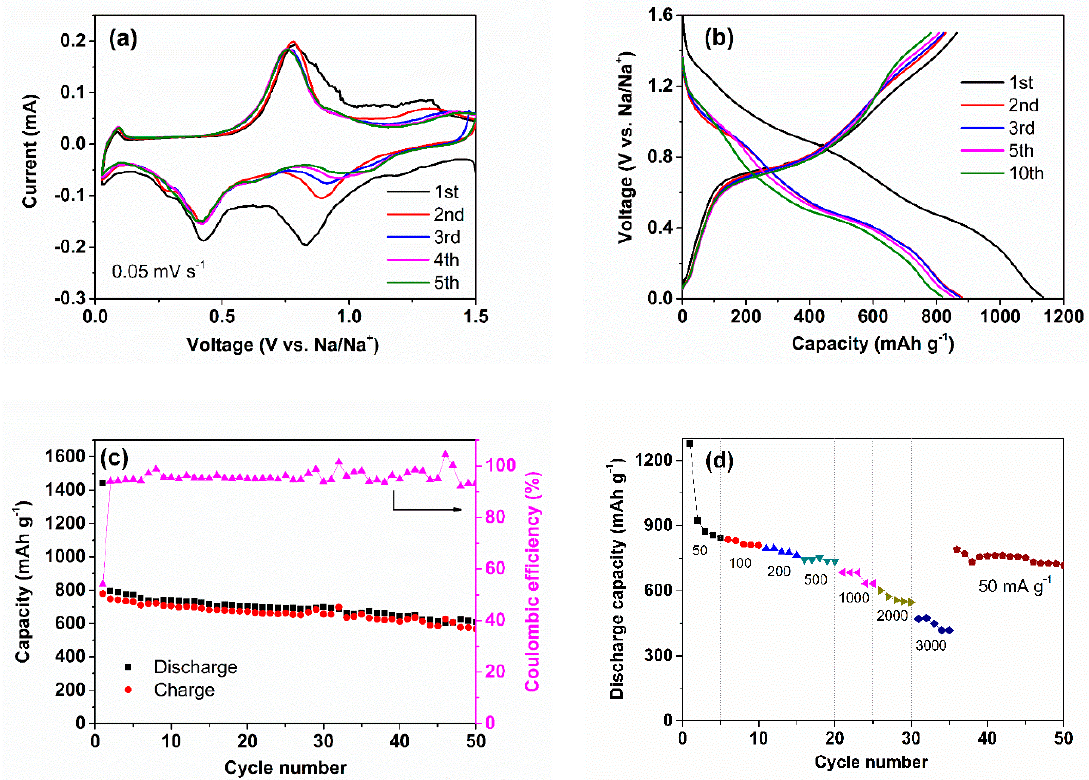
Figure 3. Electrochemical properties of the Sb 2 S 3 / CNT anode for Na-ion batteries (NIBs) in a voltage range of 0.01–1.5 V. ( a ) Cyclic voltammetry (CV) curves, ( b ) galvanostatic discharge-charge profiles measured under a current density of 100 mA g − 1 , ( c ) cycling performance at 100 mA g − 1 and ( d ) rate capability. Table 1. Comparison of the electrochemical performance of the amorphous Sb 2 S 3 / CNT nanocomposites in this work, and those previously reported for Sb 2 S 3 -based anode materials for NIBs.